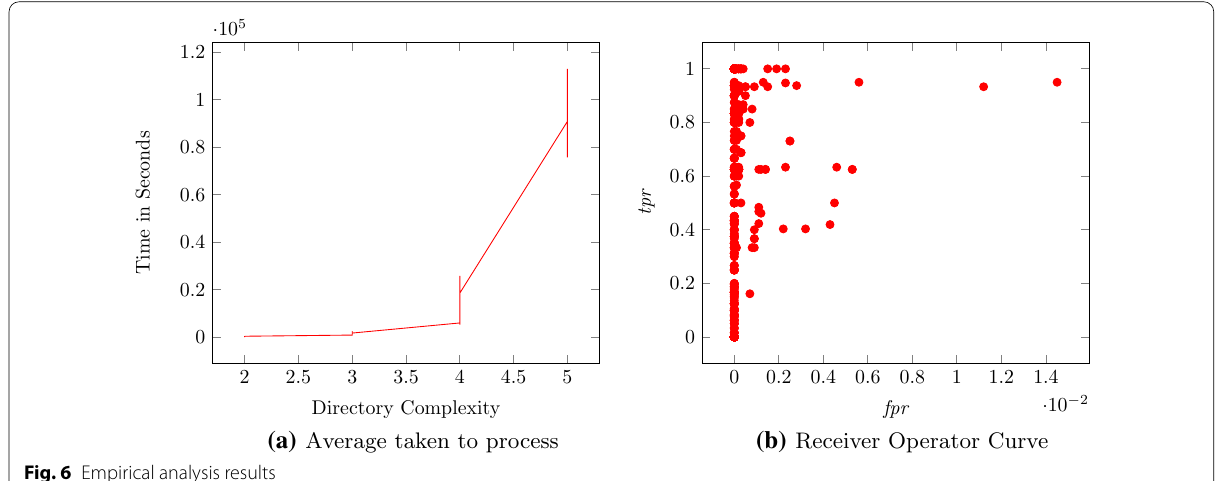
Fig. 6 Empirical analysis results